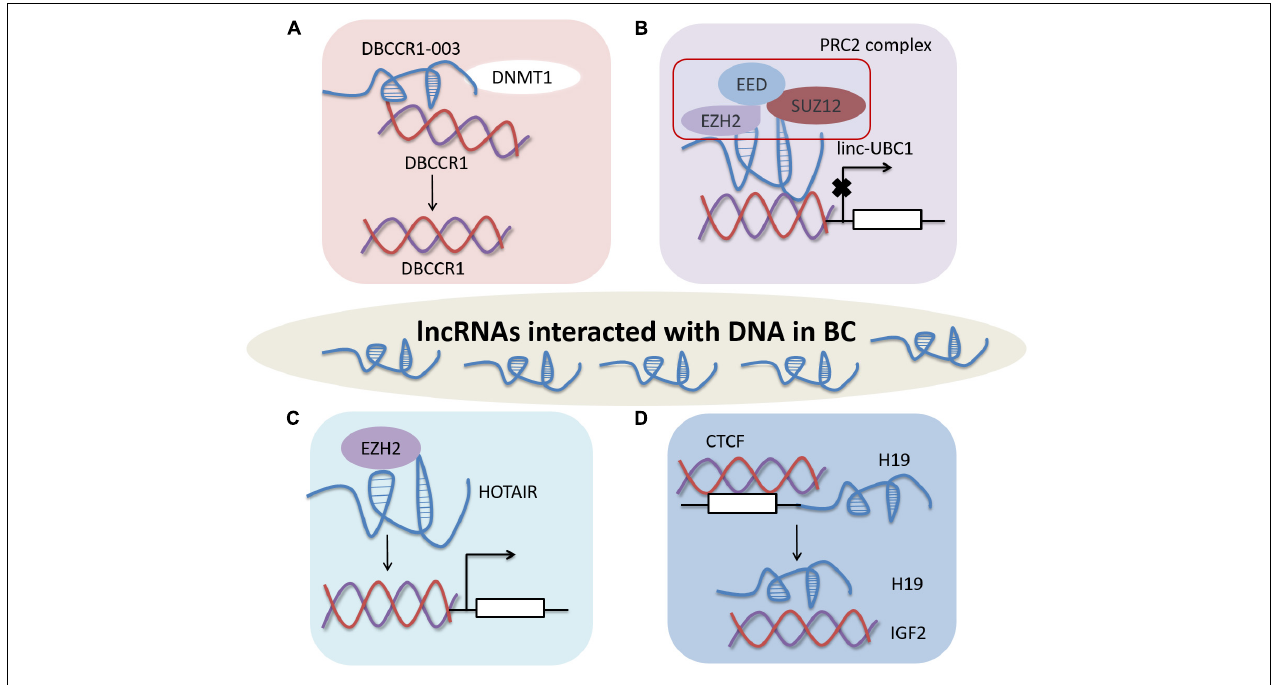
FIGURE 1 | LncRNAs affect BC by interacting with DNA. (A) DBCCR1-003 regulates the expression of DBCCR1 by binding to DNMT1 and inhibiting DNMT1-mediated methylation of DBCCR1. (B) Linc-UBC1 modulating the PRC2 complex by combining with EZH2 and SUZ12. (C) HOTAIR modulates gene expression by binding to EZH2. (D) CTCF regulates expression of H19 by methylating the H19 promoter in human